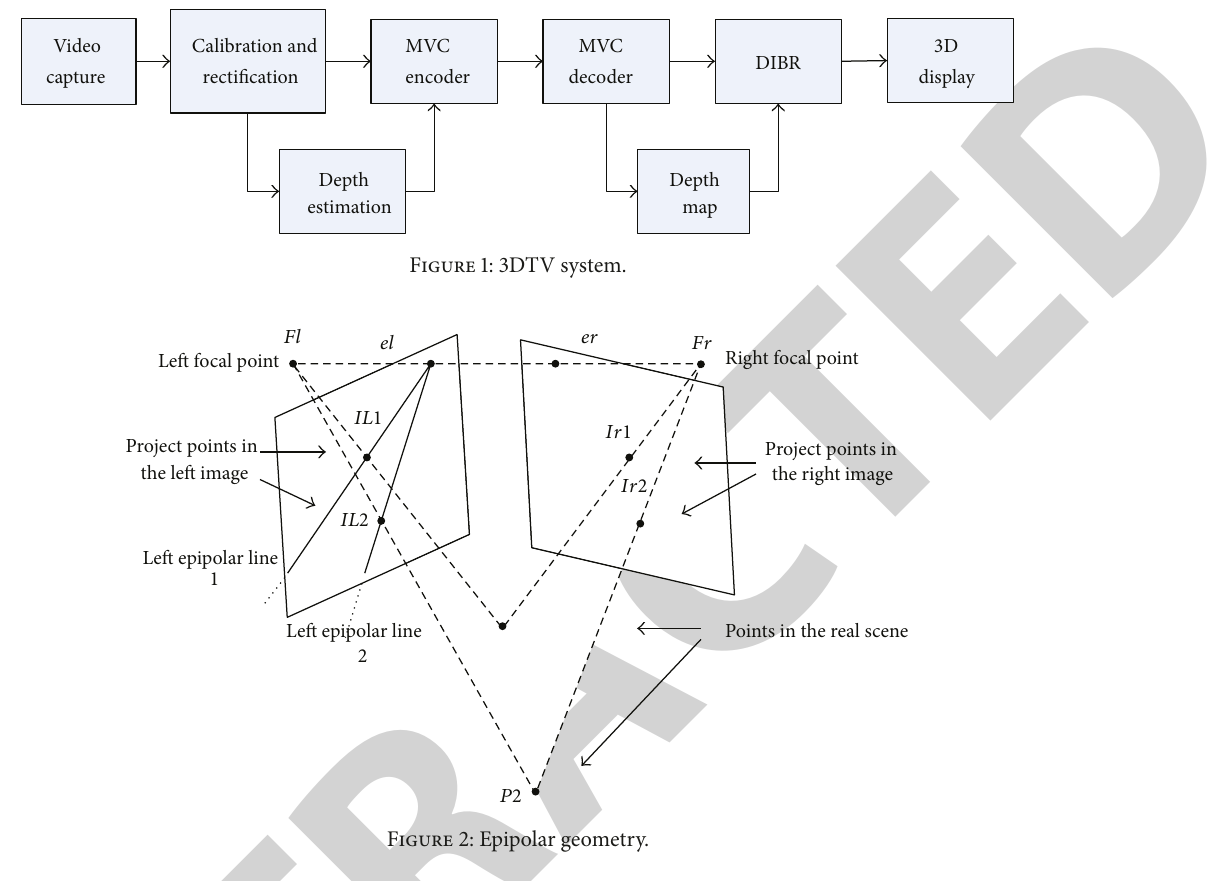
Figure 2: Epipolar